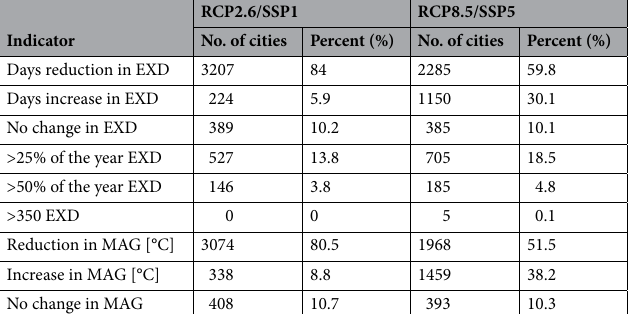
Table 1. Number and share of cities affected by changes in exposure from 1991–2000 to 2090–2099. Exposure outcomes by indicator across the 3820 world cities comparing RCP2.6/SSP1 and